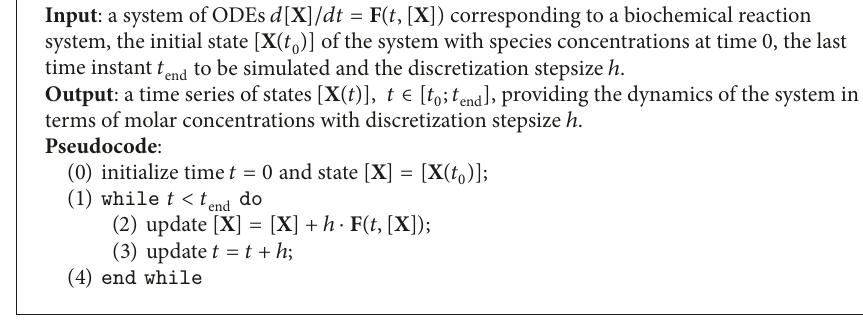
Algorithm 3: Forward Euler